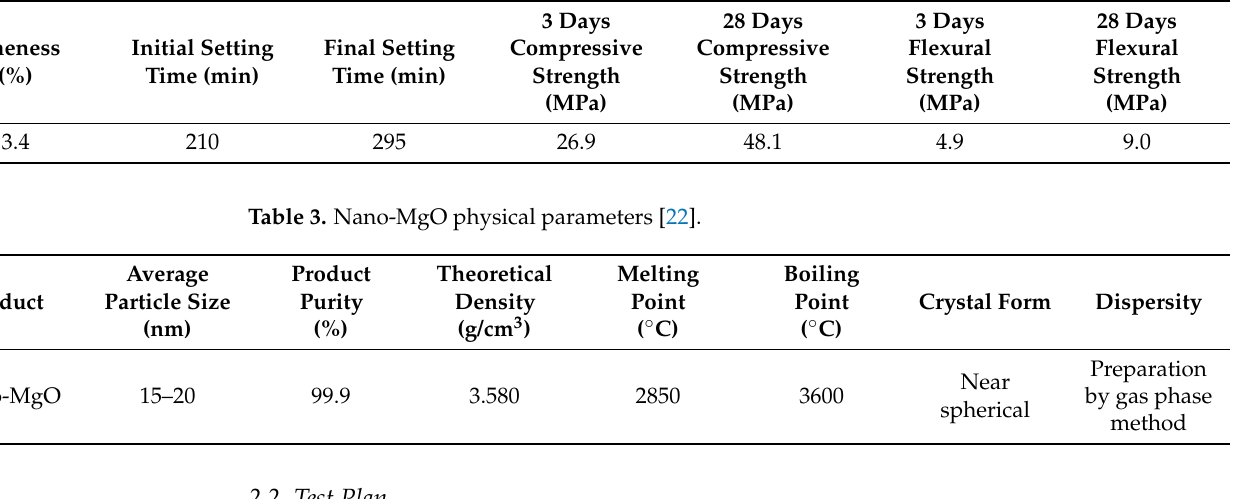
Table 2. Physical performance indexes of PO32.5 cement [21].